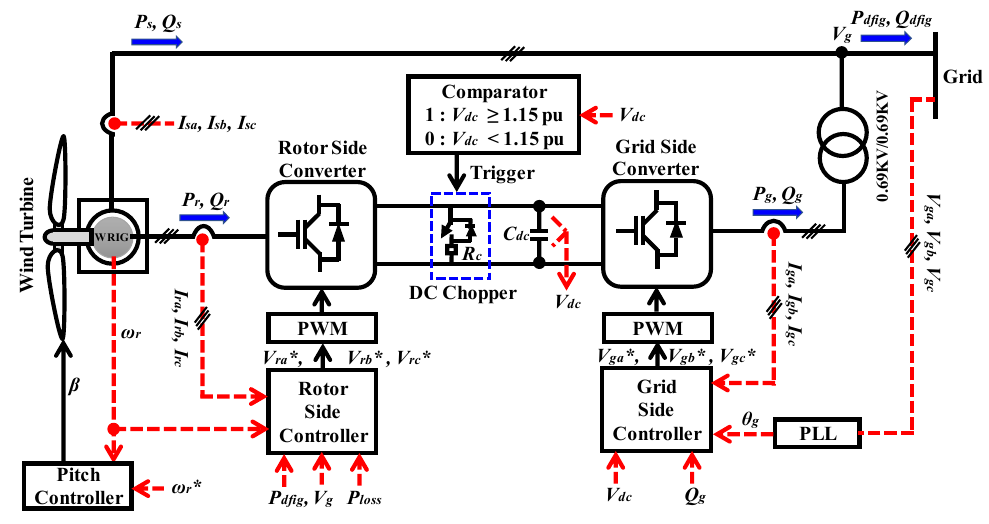
Figure 5. Configuration of the VSWT ‐ DFIG system.